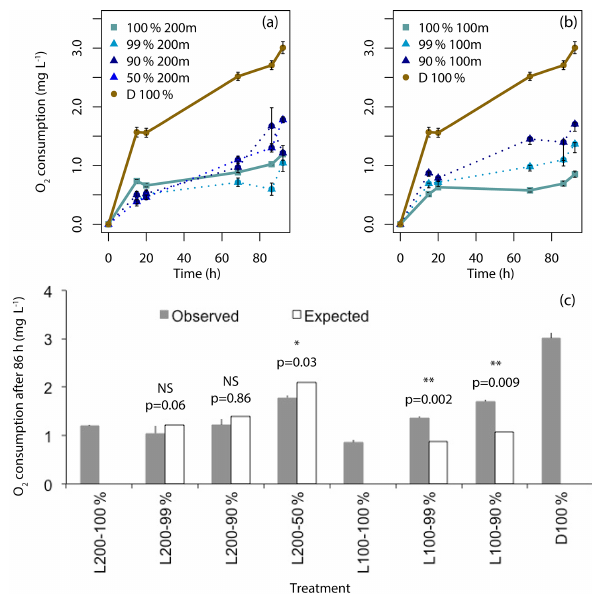
Figure 6. O 2 consumption in the bioassays. (a) Bioassays con- ducted for the lake water collected in the lowermost hypolimnion at 200m depth (100% 200m) and with 1, 10, and 50% substitu- tion with Dranse water (99% 200m, 90% 200m, and 50% 200m) and compared for Dranse water only (D 100%). (b) Bioassays con- ducted for the lake water collected in the uppermost hypolimnion at 100m depth (100% 100m), with 1 and 10% substitution with Dranse water (99% 100m, 90% 100m) and compared for the Dranse water (D 100%). (c) Expected (based on a linear mixing model) and observed (average ± SD on triplicates) O 2 consumption values after 86h incubation of mixed lake and river-borne waters. Specified p values correspond to the outputs of the Student’s tests comparing observed and theoretical, expected